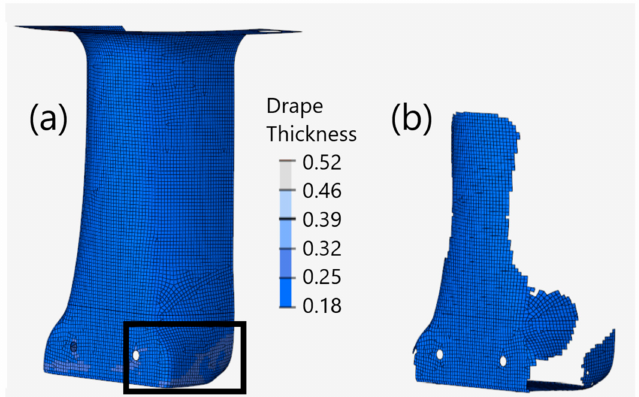
Figure 14. Example of thickness variation in one ply in the draped partitioned model before ( a ), and after ( b ), topology